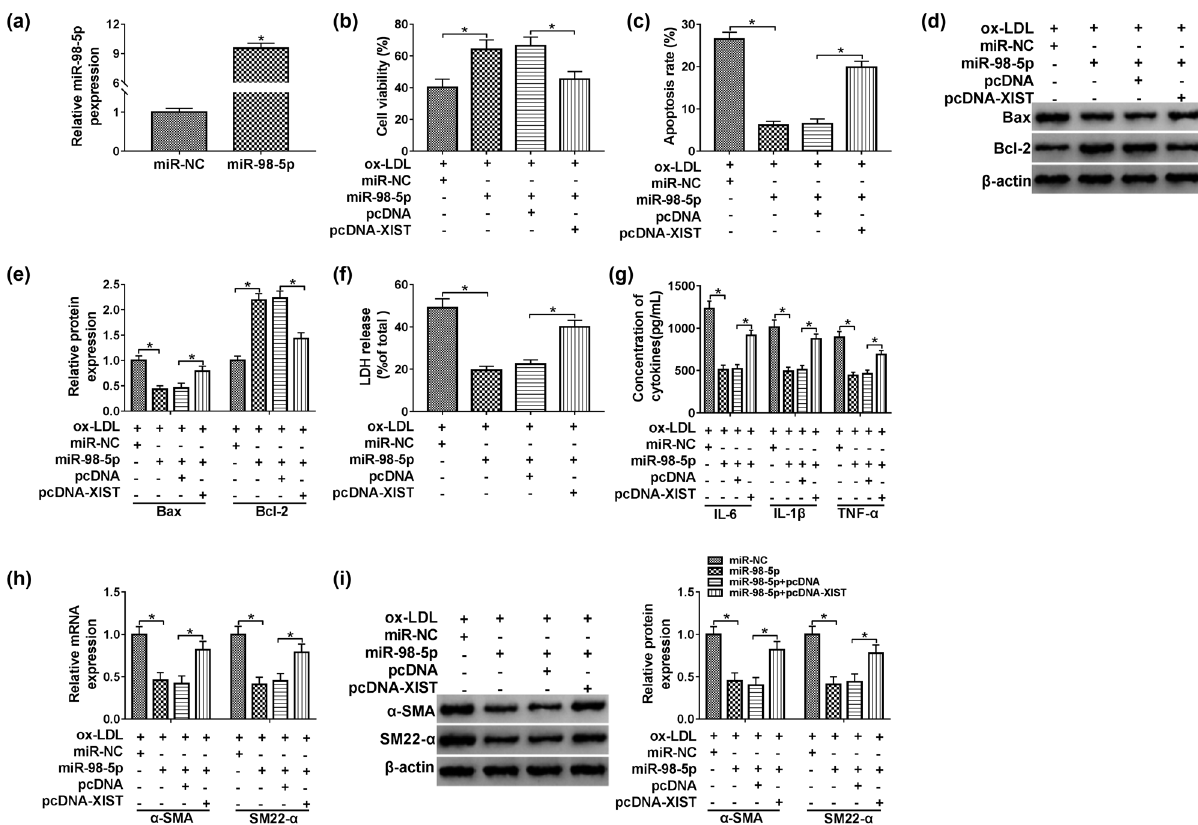
Figure 4: Ox - LDL repressed proliferation and induced apoptosis and in fl ammatory response in HUVECs by targeting the XIST/miR - 98 - 5p axis. ( a ) QPCR was enforced to con fi rm the overexpression e ffi ciency of miR - 98 - 5p in HUVECs. ( b – i ) HUVECs were treated with ox - LDL + miR - NC, ox - LDL + miR - 98 - 5p, ox - LDL + miR - 98 - 5p + pcDNA, or ox - LDL + miR - 98 - 5p + pcDNA - XIST. ( b ) MTT assay was used to assess cell viability of HUVECs. ( c ) Cells apoptosis assay was performed in transfected HUVECs by fl ow cytometry assay. ( d and e ) The protein expression levels of Bax and Bcl - 2 were calculated in HUVECs by western blot assay. ( f ) The LDH release was displayed in the di ff erent groups by kit assay. ( g ) The concentrations of IL - 6, IL - 1 β , and TNF - α in the medium were presented by ELISA assay. ( h and i ) The mRNA and protein expression levels of α - SMA and SM22 - α in HUVECs were detected by qPCR and western blot assays, respectively. Data shown are mean ± SD and from three independent experiments. * P <